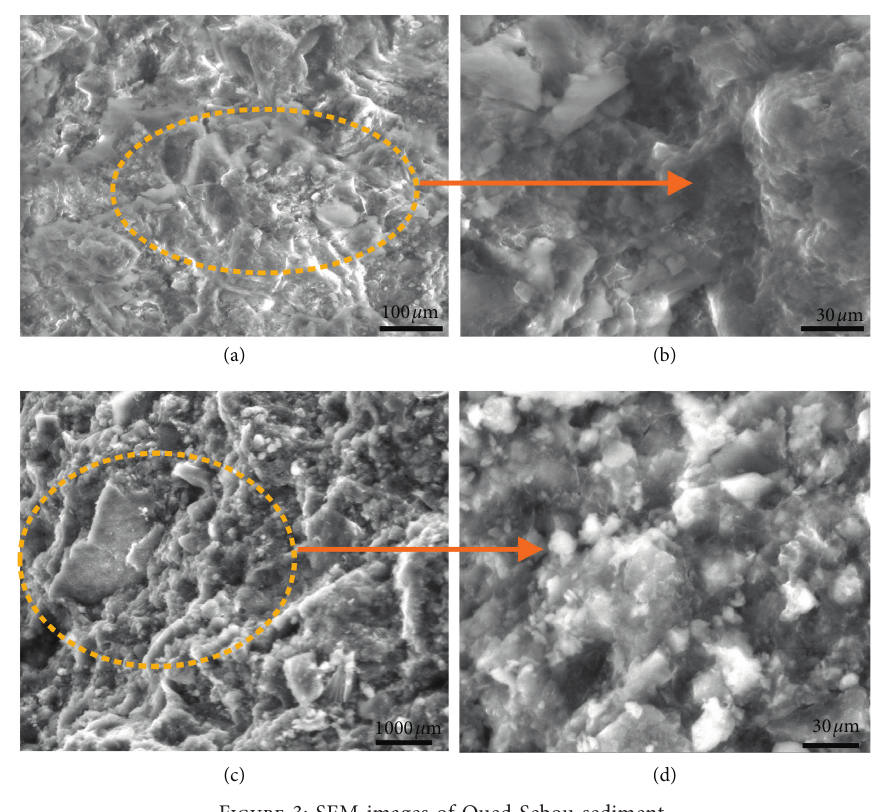
Figure 3: SEM images of Oued Sebou sediment.